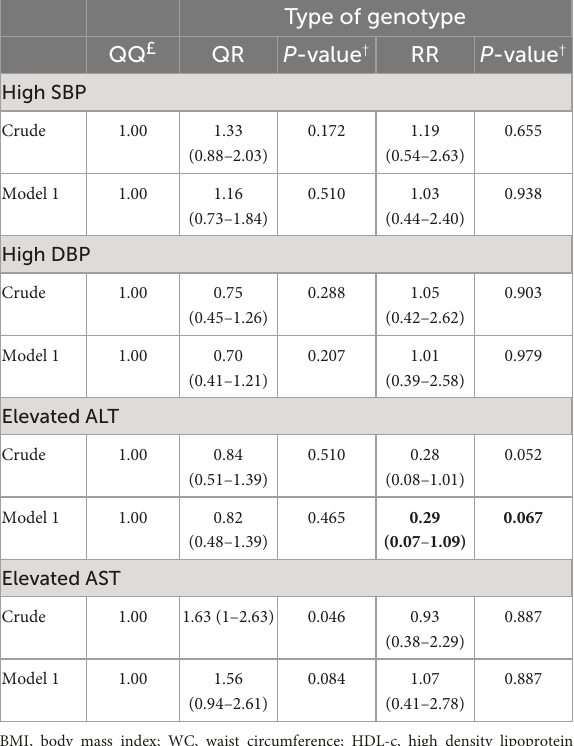
TABLE 4 Multivariable adjusted odds ratios and 95% CI of rs662 polymorphism on BMI, HDL-C, and ALT stratified by sex.